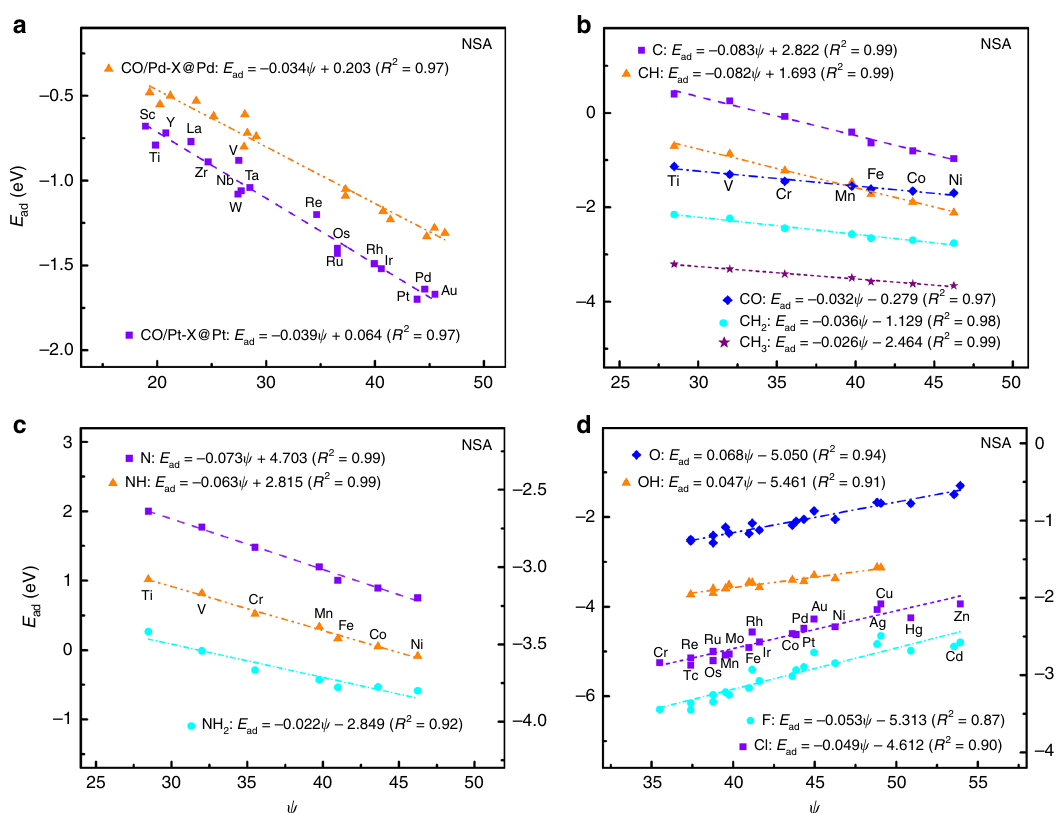
Fig. 4 Adsorption energies of small molecules on near-surface alloys (NSAs) as a function of the electronic descriptor ψ . a CO on (100) surface of the Pt- and Pd-NSAs 48 . b – d CH x and CO ( b ), N and NH x 47 ( c ), OH x , F, and Cl 30,38 ( d ) on (111) surface of the Pt-NSAs. In each panel, the adsorption energies of adsorbates are linearly correlated with the electronic descriptor ψ . The adsorbate name, the color code, and the linear fi ts are provided as insets and the corresponding parameters are summarized in Supplementary Table 12. In each sub fi gure with both the left and right axes, the linear fi ts at the upper left corner correspond to the left coordinate axis and those at the bottom right corner correspond to the right coordinate axis. Clearly, the adsorption energy scales linearly with ψ , whereas the slope k is governed by electron-counting rules and can be described by the unsaturated bond number of the central atom in adsorbates. Source data are provided as a Source Data fi